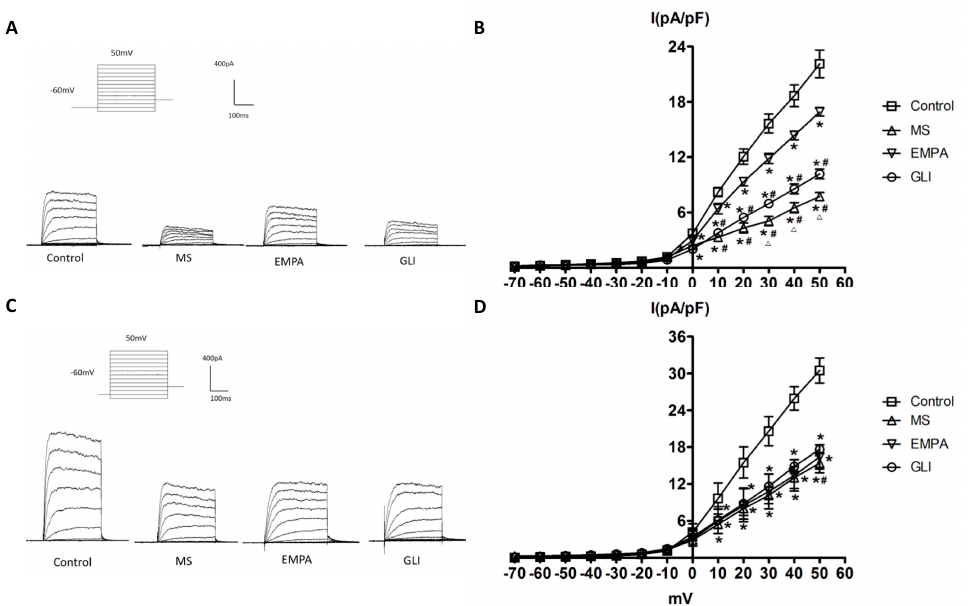
Figure 2. Effects of adipocytokines from the pericardial and peripheral fat tissues of the study groups on the delayed-rectifier potassium current (I K ) in H9c2 cells. ( A ) Representative recordings of I K elicited by 300 ms of depolarizing step pulses from − 70 to 50 mV at a holding potential of − 60 mV in H9c2